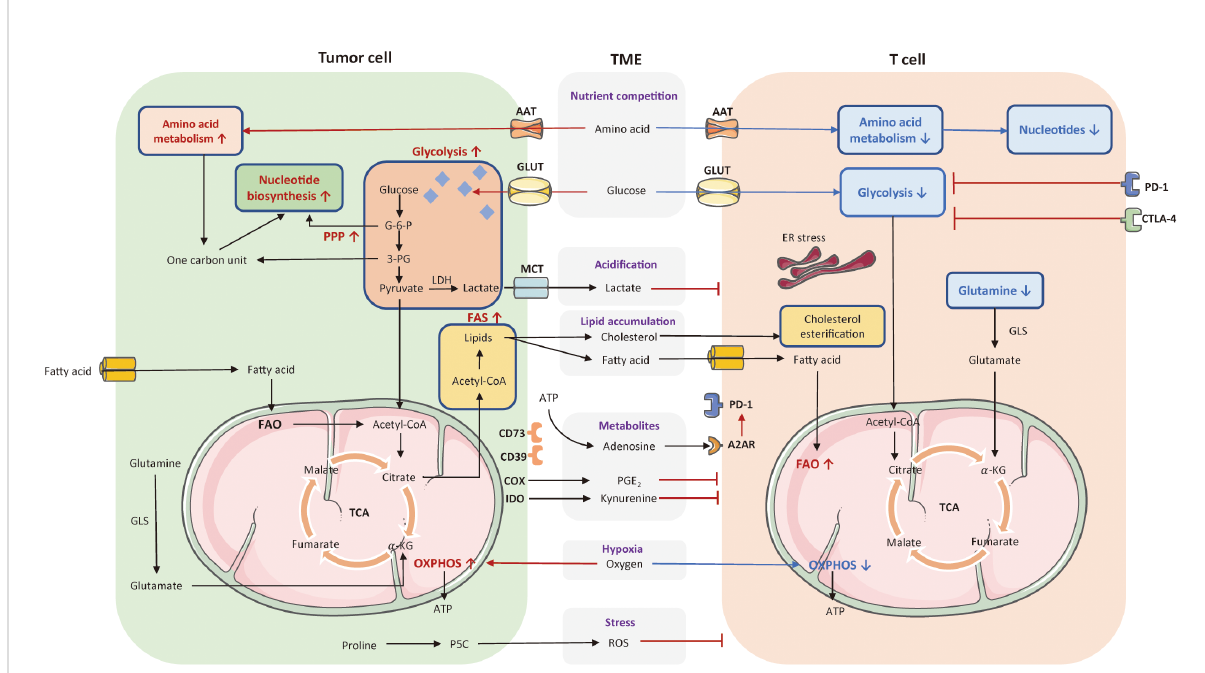
FIGURE 2 The metabolic communication and competition between tumor cells and T cell. Cellular metabolic disturbances lead to a highly acidic, hypoxic, oxidative stressed, and immunosuppressive tumor microenvironment (TME), which profoundly affect T cell anti-tumor responses. Tumor cells consume a large amount of glucose and amino acids to fuel their rapid proliferation. These pathways greatly limited nutrient and availability to T cells in the TME. The enhanced glycolysis in tumor cells also induce the generation of lactate that can acidify the TME and exert an immunosuppressive effect on T cells. Tumor cells with enhanced FAS lead to lipid accumulation in the TME, including fatty acid and cholesterol, variously affecting T cell function. Also, tumors cells released several cancer metabolites, such as adenosines, kynurenines, prostaglandins, which suppress T cell effector function. Moreover, tumor cells consume a high level of oxygen to favor OXPHOS, contributing to hypoxia in the TME along with the production of ROS, and thereby inhibiting T cell anti-tumor functionality. The red arrows and texts represent enhanced metabolism processes, while the blue arrows and texts represent inhibited metabolic pathways. PPP, pentose phosphate pathway; OXPHOS, oxidative phosphorylation; FAO, fatty acid oxidation; FAS, fatty acid synthesis; TCA, tricarboxylic acid; AAT, amino acid transporter; GLUT, glucose transporter; MCT, monocarboxylate transporter; G-6-P, glucose-6-phosphate; 3-PG, 3-phosphoglyceric acid; LDH, lactate dehydrogenase; GLS, glutaminase; ATP, adenosine triphosphate; A2AR, A2A receptor; PGE 2 , prostaglandins, COX, cyclo-oxygenase; IDO, indoleamine 2,3-dioxygenase; ROS, reactive oxygen species; ER, endoplasmic reticulum; TME, tumor microenvironment; MPC, mitochondrial pyruvate